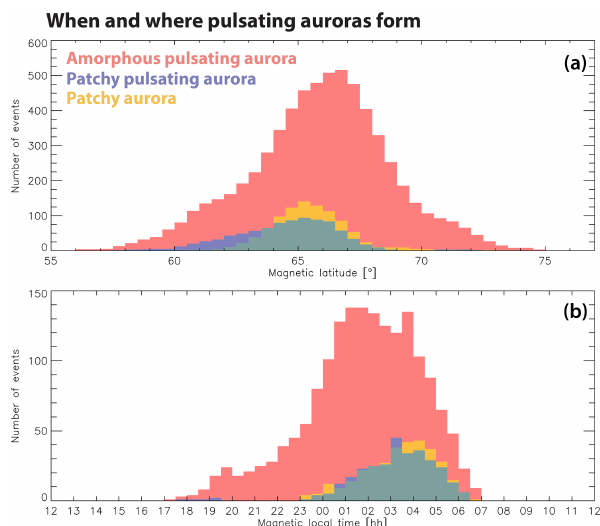
Figure 5. Figure 4 reduced in dimension to separate histograms in MLT and MLAT to allow easier comparison of occurrence between the types of pulsating aurora.